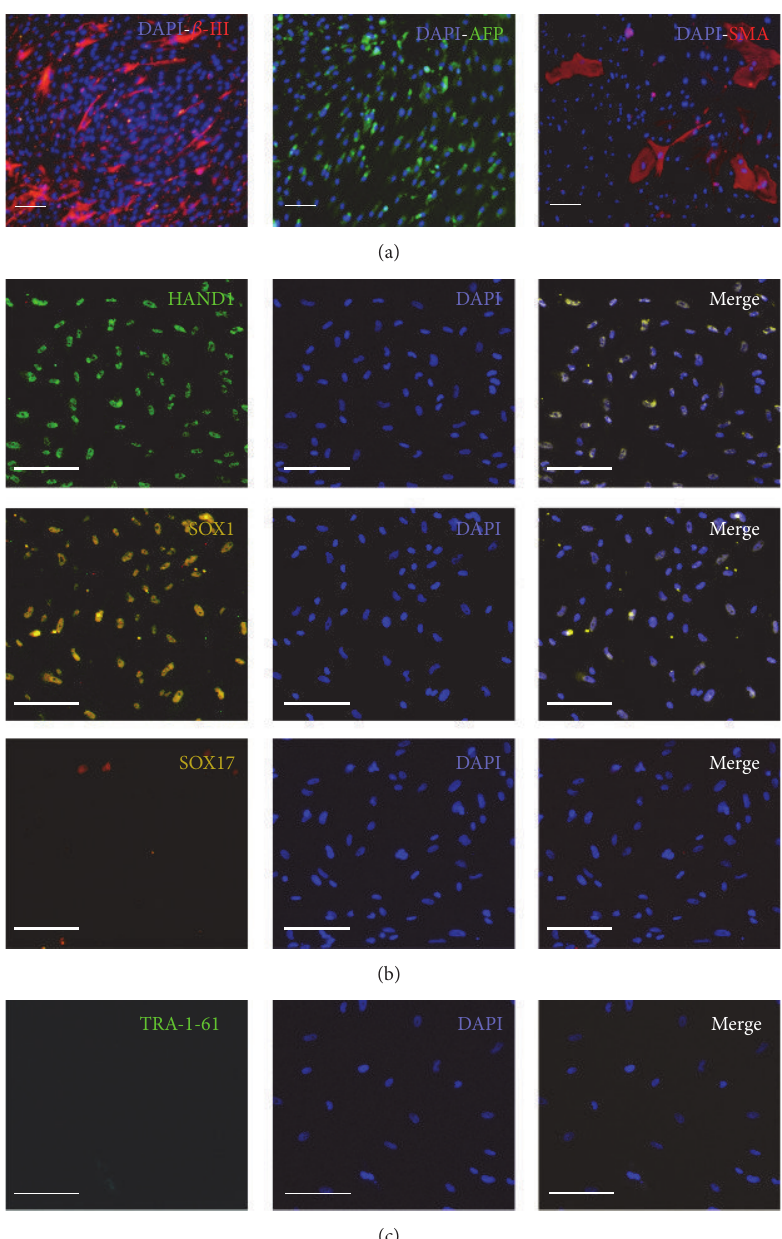
Figure 3: Differentiation of hOB-iPSCs into trilineages. (a) hOB-iPSC embryoid bodies (EBs) labeled with antibodies for cytoplasmic germ- layer markers, 𝛽 -III tubulin ( 𝛽 -III; ectoderm), AFP (endoderm), and SMA (mesoderm). (b) hOB-iPSC EBs labeled with antibodies for germ- layer transcription factors, HAND1 (mesoderm), Sox1 (ectoderm), and Sox17 (endoderm). (c) Undetectable staining for pluripotent cells with TRA-1-60. Scale bars = 40 𝜇